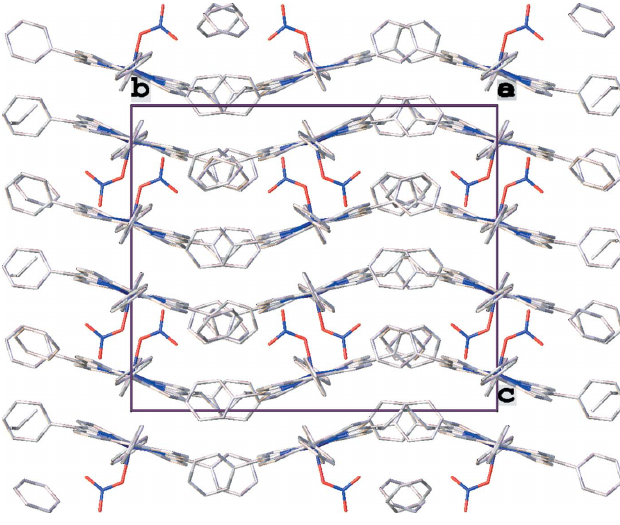
Figure 3 The C—H (cid:2)(cid:2)(cid:2) O interactions between the apical nitrato ligand and the benzene solvent